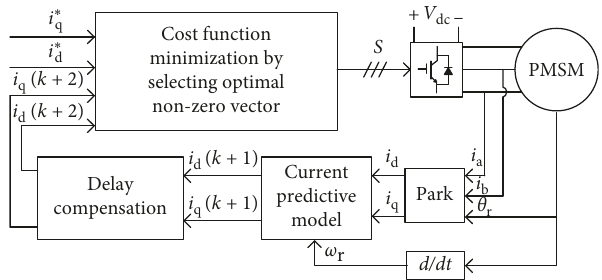
Figure 2: The control diagram of the conventional MPC-RCMV